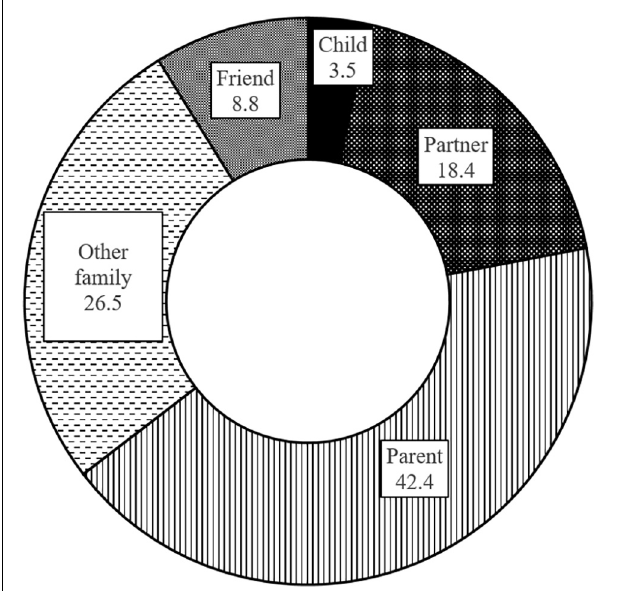
FIGURE 1 | Relationship with the deceased person in